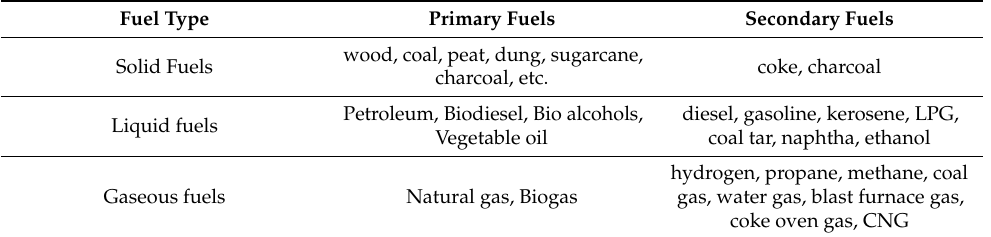
Table 1. General classification of fuels.